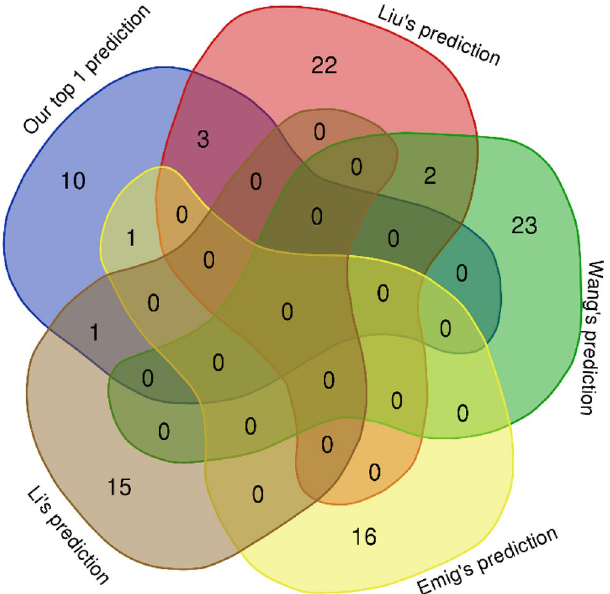
Figure 5. Comparison with other prediction results. The Venn diagram was drawn based on the intersection of the predicted anticancer drug target genes in four previous reports and our top 1 prediction. Our top 1 prediction shares consistency with the most predictions of different methods, i.e., 3 out of 4 predictions. The figure was drawn with the online tool http:// bioin forma tics. psb. ugent. be/ webto ols/